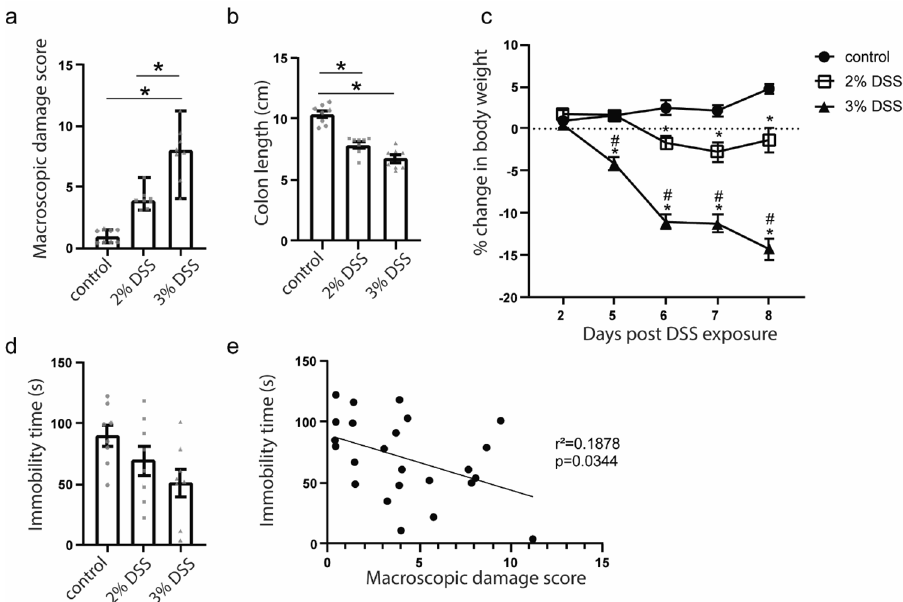
Figure 1. Exposure to DSS promotes colon shortening, weight loss, and macroscopic damage in the colon, which is negatively correlated with reduced immobility time in the forced swim task. ( a ) Macroscopic damage score; Kruskal Wallis, Dunn’s post-test *p < 0.05 relative to control. Data shown are median ± 95% CI. ( b ) Colon length; One Way ANOVA, Dunnett’s post-test, *p < 0.05 relative to control. Data shown are mean ± SEM. ( c ) Change in body weight over course of DSS exposure; two-way ANOVA, Tukey’s post-test; *p < 0.05 versus control, # p < 0.05 versus 2%DSS treatment. Data shown are mean ± SEM. ( d ) Total immobility time in the forced swim task; One-way ANOVA, p = 0.0627. Data shown are mean ± SEM. ( e ) Immobility time as a function of macroscopic damage score; linear regression. N = 8 per